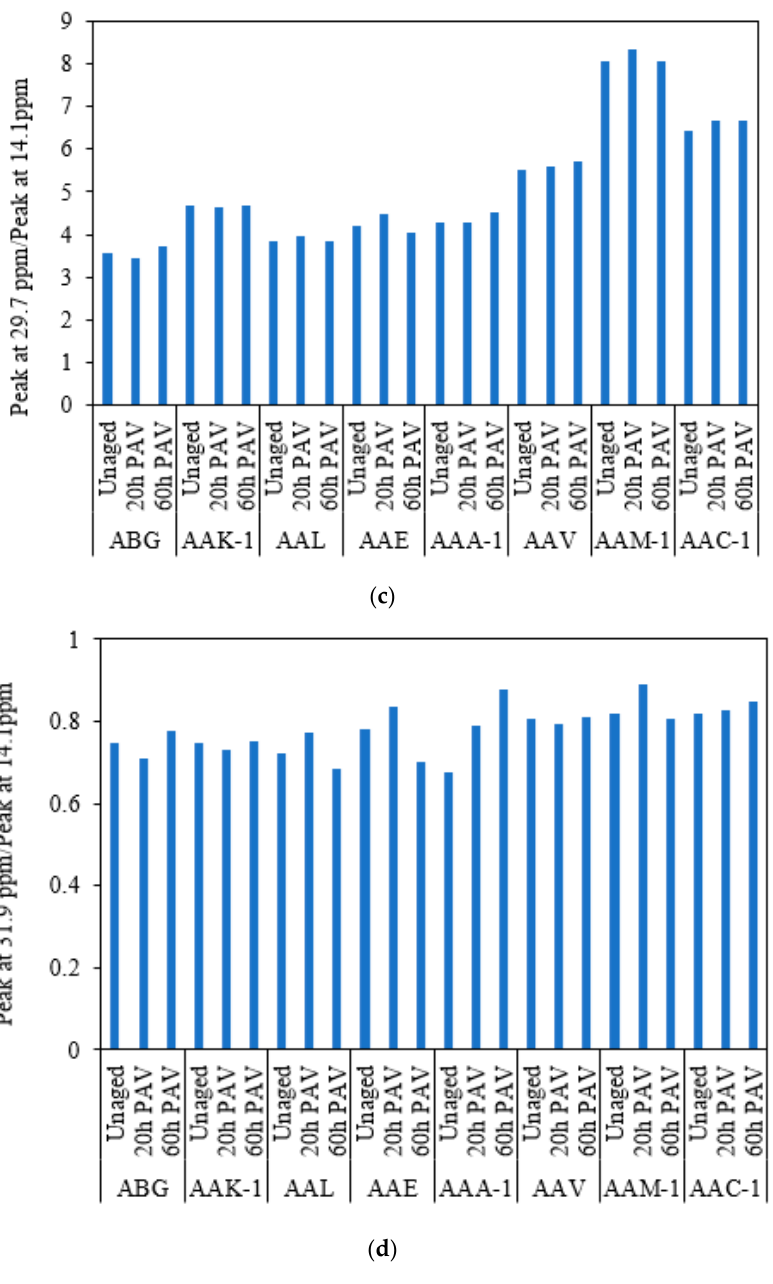
Figure 2. Percent carbons from 13 C NMR for SHRP asphalt binders. ( a ) Peak@22.7 ppm/Peak@14.1 ppm ( b ) Peak@29.1 ppm/Peak@14.1 ppm ( c ) Peak@29.7 ppm/Peak@14.1 ppm ( d ) Peak@31.9 ppm/Peak@14.1